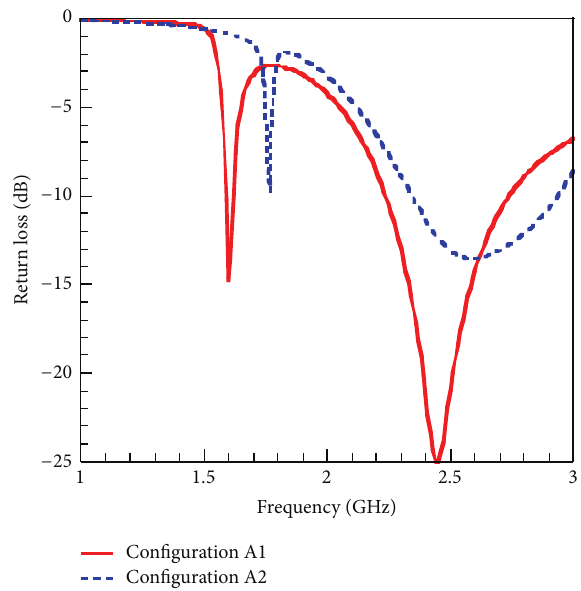
Figure 3: Simulated return loss of the proposed antennas.